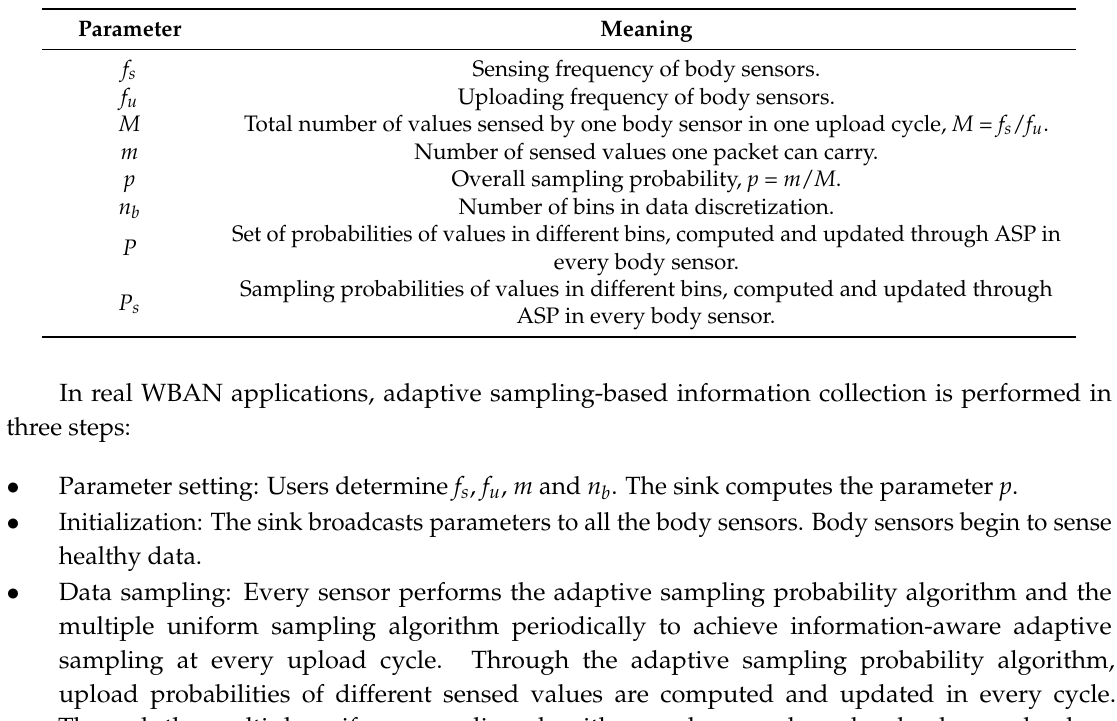
Table 1. Parameters Used in